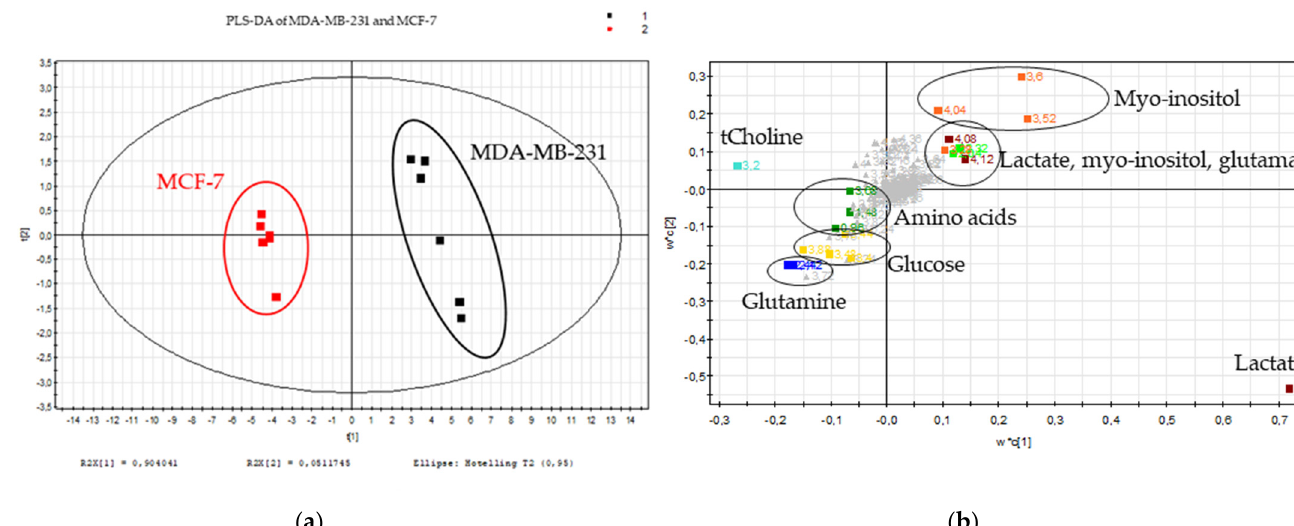
Figure 1. Metabolic signature of the breast cancer cell lines. ( a ) Scores plot and ( b ) loadings plot of the PLS-DA of the MDA-MB-231 (black) and MCF-7 (red) cellular polar extracts ( n = 6); burgundy: lactate, orange: myo-inositol, light green: glutamate, dark green: amino acids (alanine and isoleucine), light blue: choline, dark blue: glutamine and yellow: glucose for 231 variables.